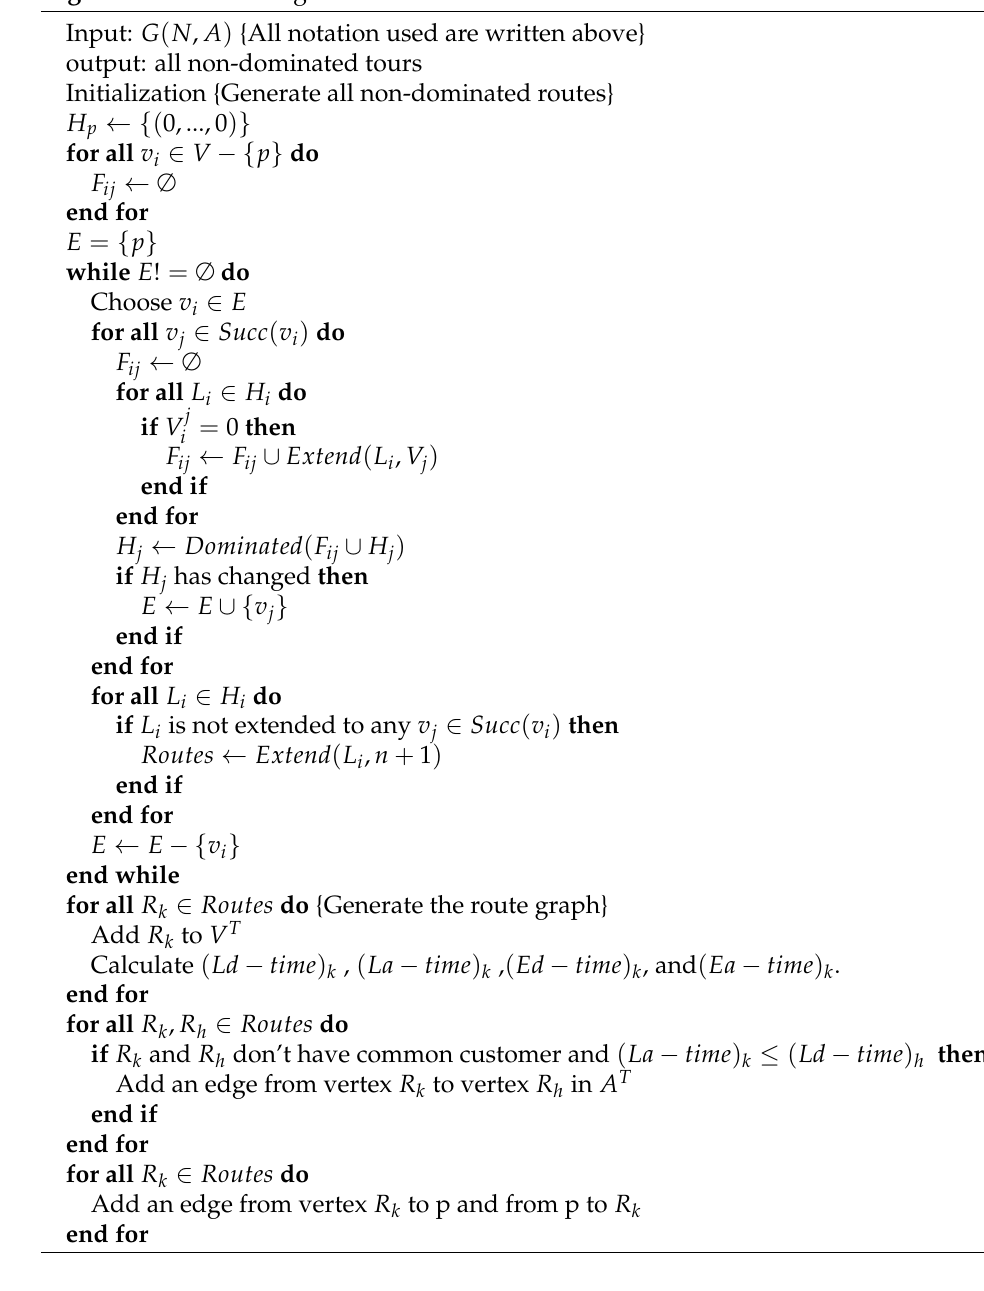
Algorithm 1 Generating all non-dominated